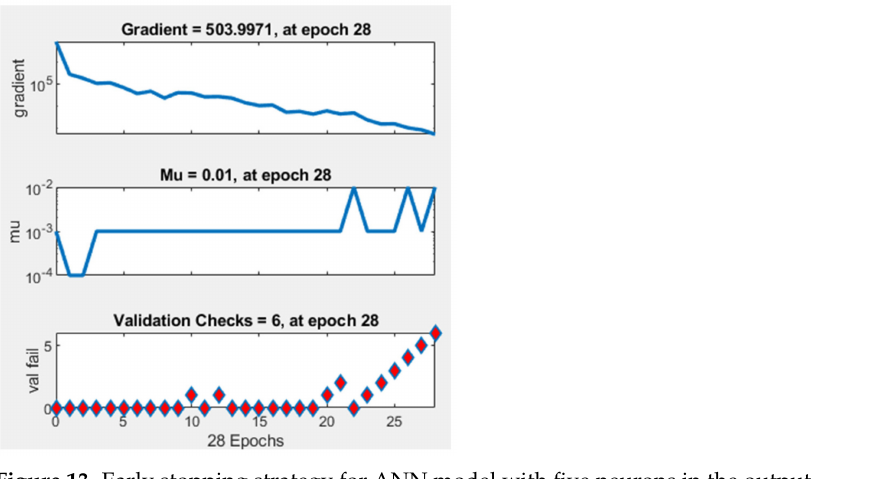
Figure 13. Early stopping strategy for ANN model with five neurons in the output.